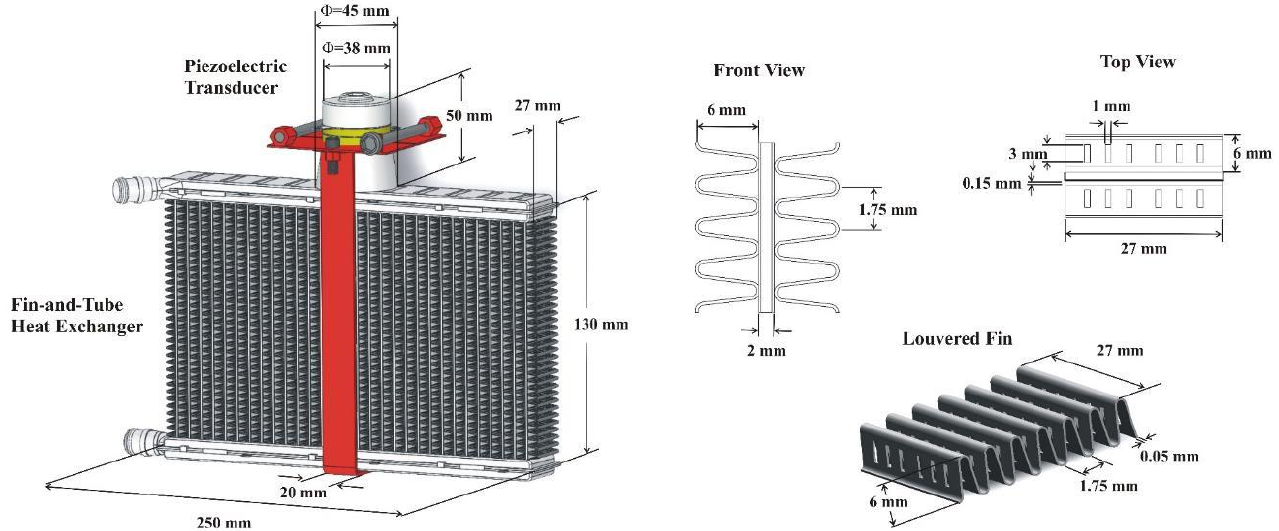
Figure 2. The schematic of the fin-and-tube heat exchanger, piezoelectric transducer, and louvered